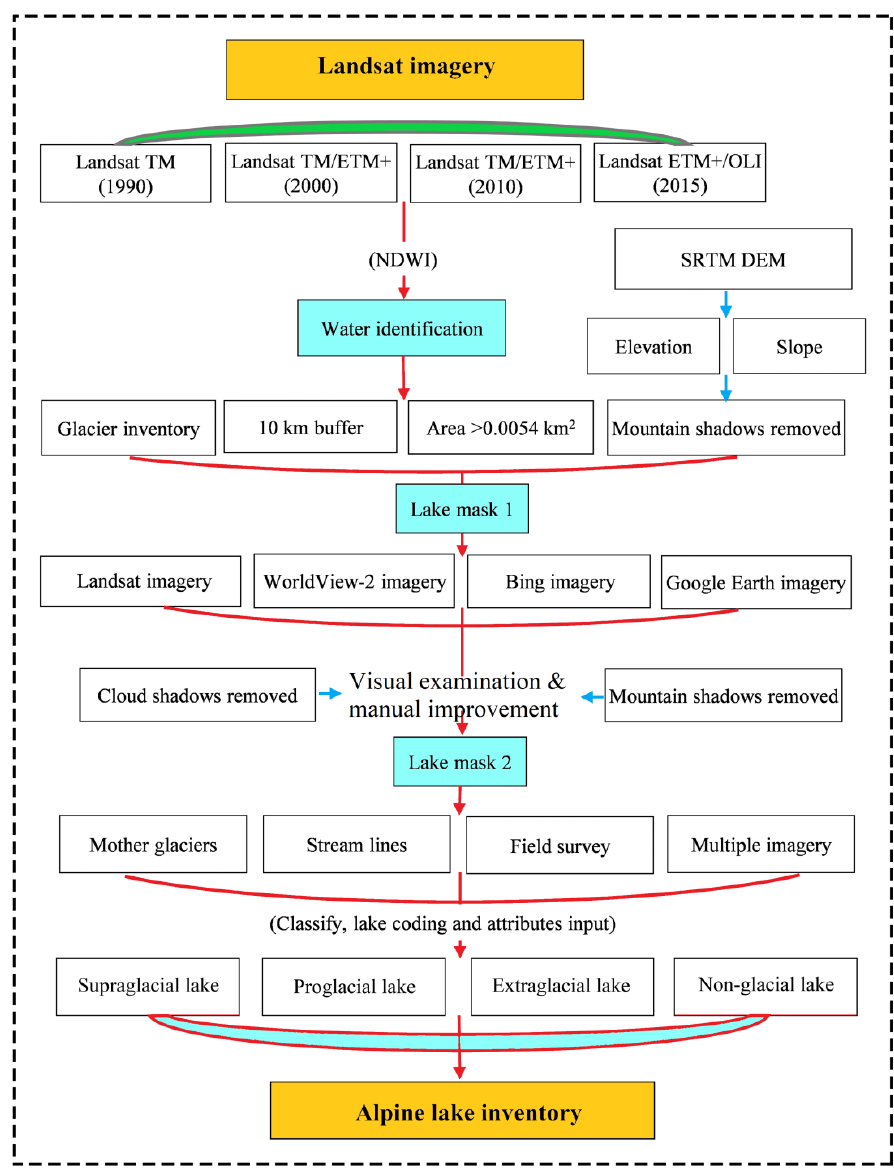
Figure 2. Flow chart showing the process used for alpine lake extraction. Overall, the maximum uncertainty in TS lake area was 14.38% for 1990, 14.99% for 2000, 15.03% for 2010 and 15.89% for 2015. To check the accuracy of the extracted lake